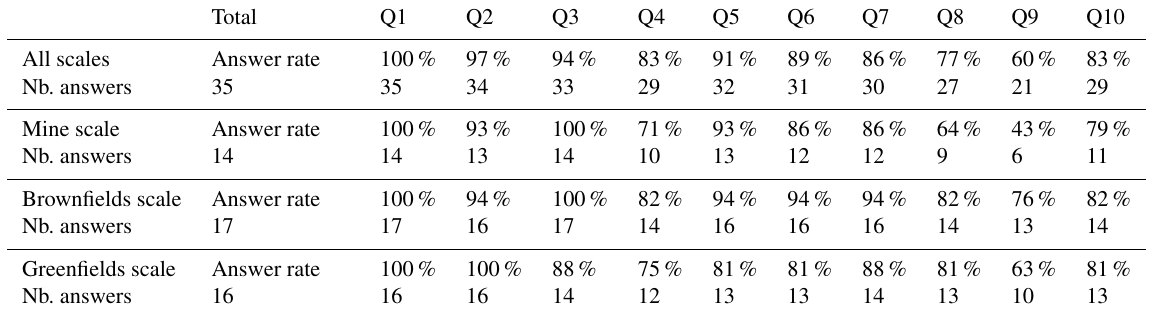
Table 1. Global number and rate of answers per question and detailed by modelling scale.